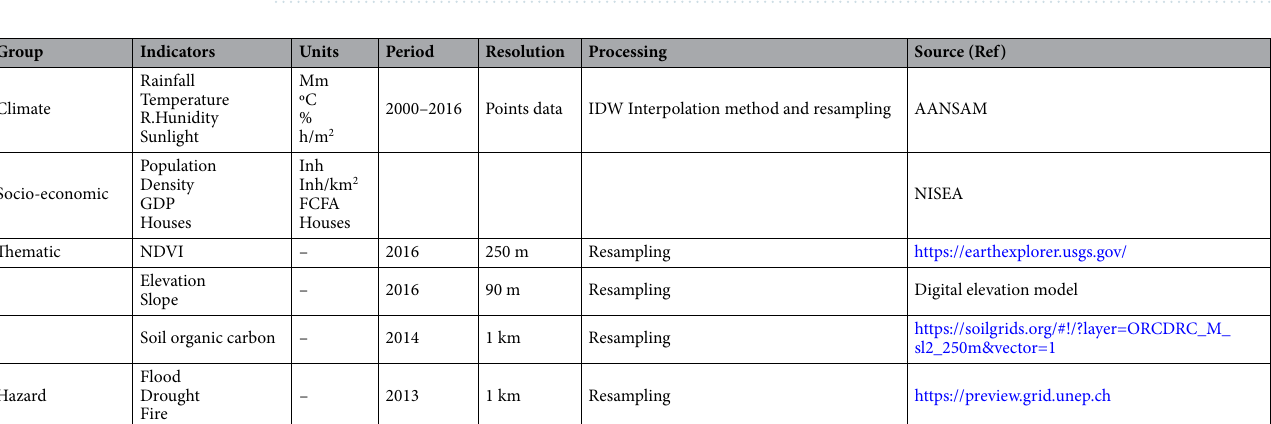
Table 1. Characteristic of data. mm = millimeter, ºC = degree Celsius, % = percentage, h/m 2 = hour per meter square, Inh. = inhabitant, Inh/km 2 = inhabitant per kilometer square, FCFA = francs des colonies françaises d’Afrique, AANSAM = Agency for Aerial Navigation Safety in Africa and Madagascar, and NISEA = National Institute for Statistics and Economic